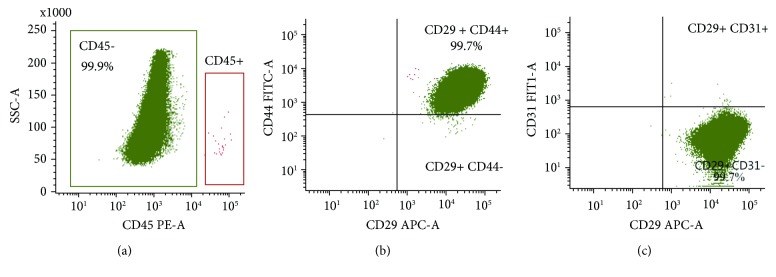
Immunophenotype of cells isolated from SVF conducted to be oADSCs. A gating of cells was based on FSC and SSC criteria, and the cells were subgated to only include single cells and only live cells were measured by fixable viability dye eFluor 506 staining and used subsequent analysis (data not shown). (a) CD45-negative cells were subgated to analyze the expression of (b) CD44 and CD29 and (c) CD31 and CD29. All quadrants were placed based on the isotype controls.